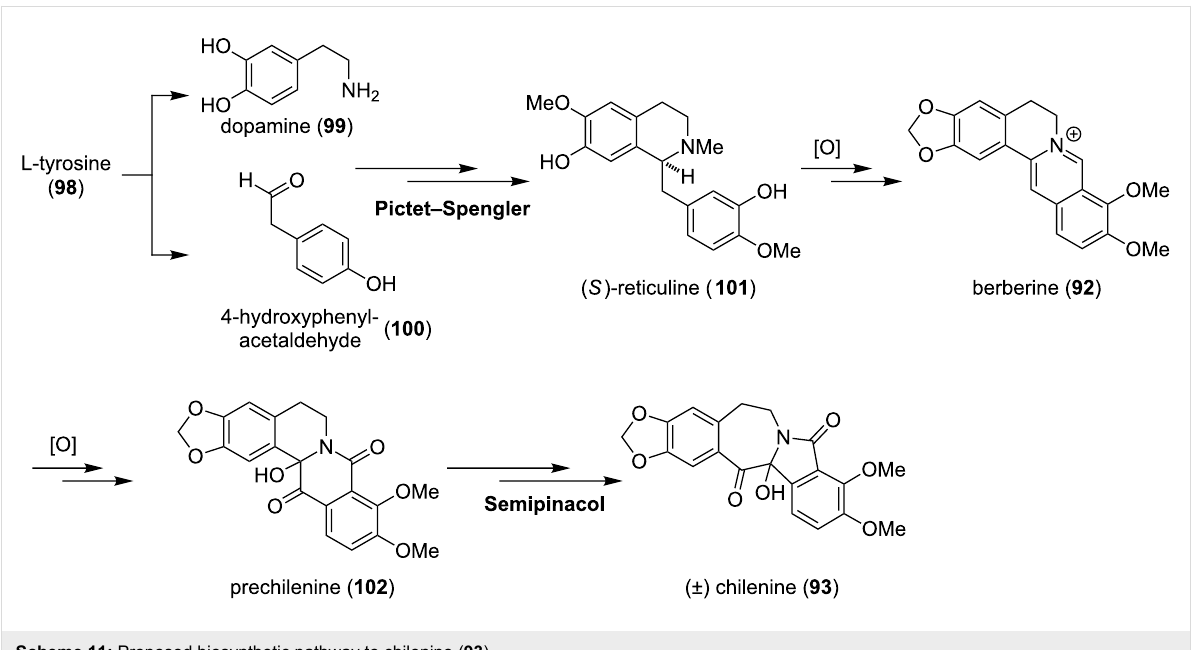
Scheme 11: Proposed biosynthetic pathway to chilenine ( 93